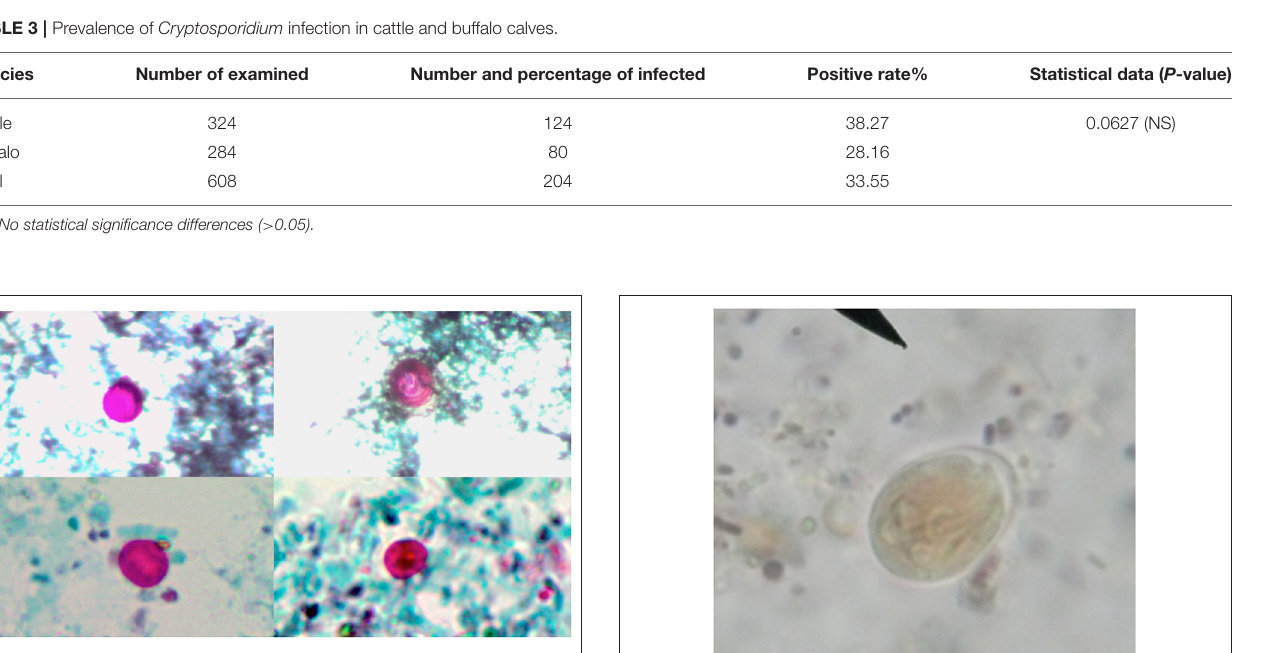
and thoroughly using a 10 × objective lens, and confirmation was made by switching to a magnification of 40 × .